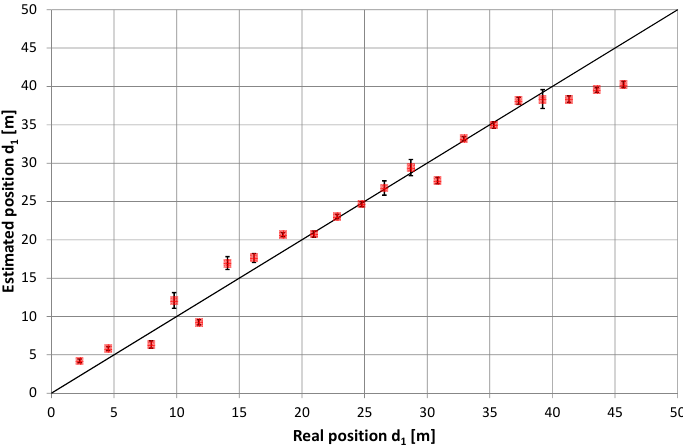
Figure 10. Results of position estimation in the scenario with return signal amplification.